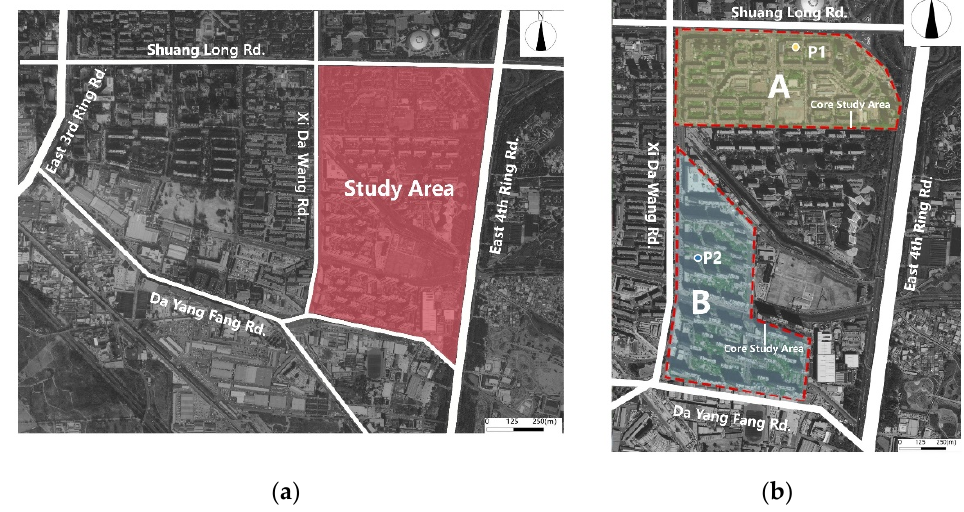
Figure 1. The study area: ( a ) the study area; ( b ) core study area, A refer to Neighborhood A, B refer to Neighborhood B.